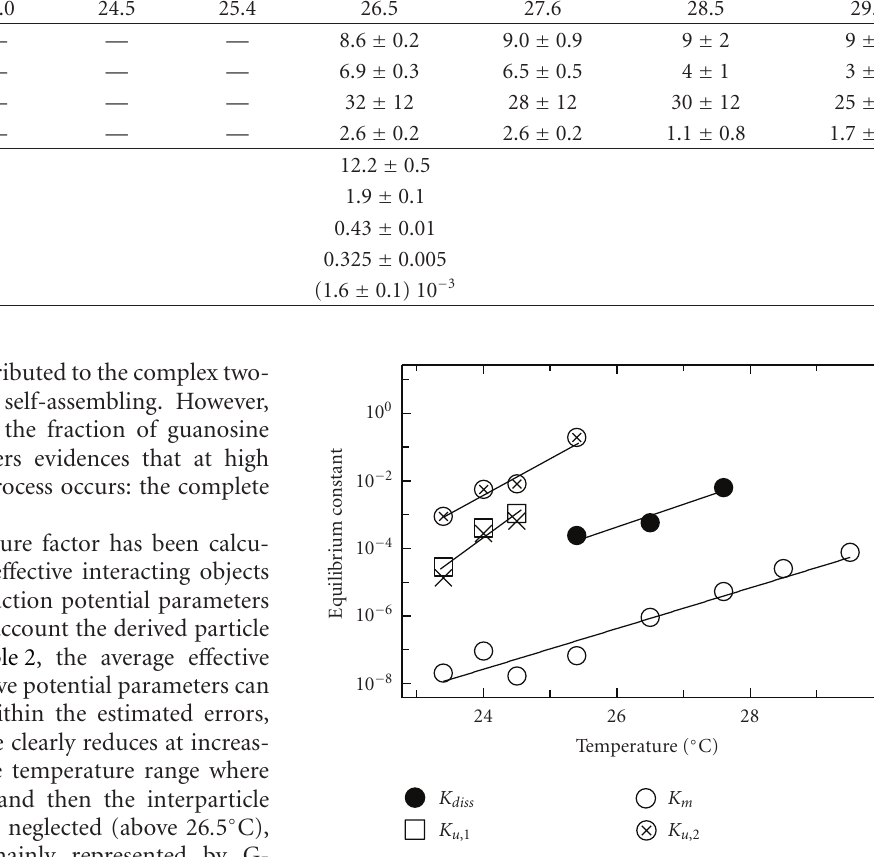
Figure 5: Temperature dependence of the equilibrium dissociation constants. Symbols are as in the text. The corresponding reactions are shown in